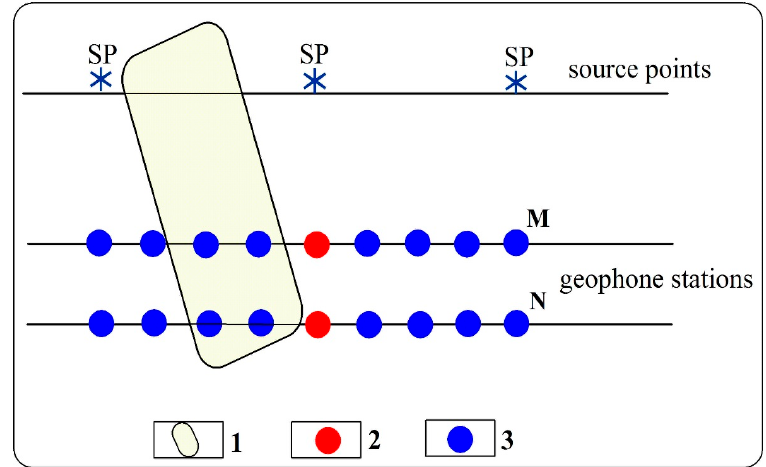
Figure 2. Piezoelectric measurement array (after [14] with some modifications): (1) projection of the piezoactive body to the earth’s surface; (2) geophone; and (3) electrode.